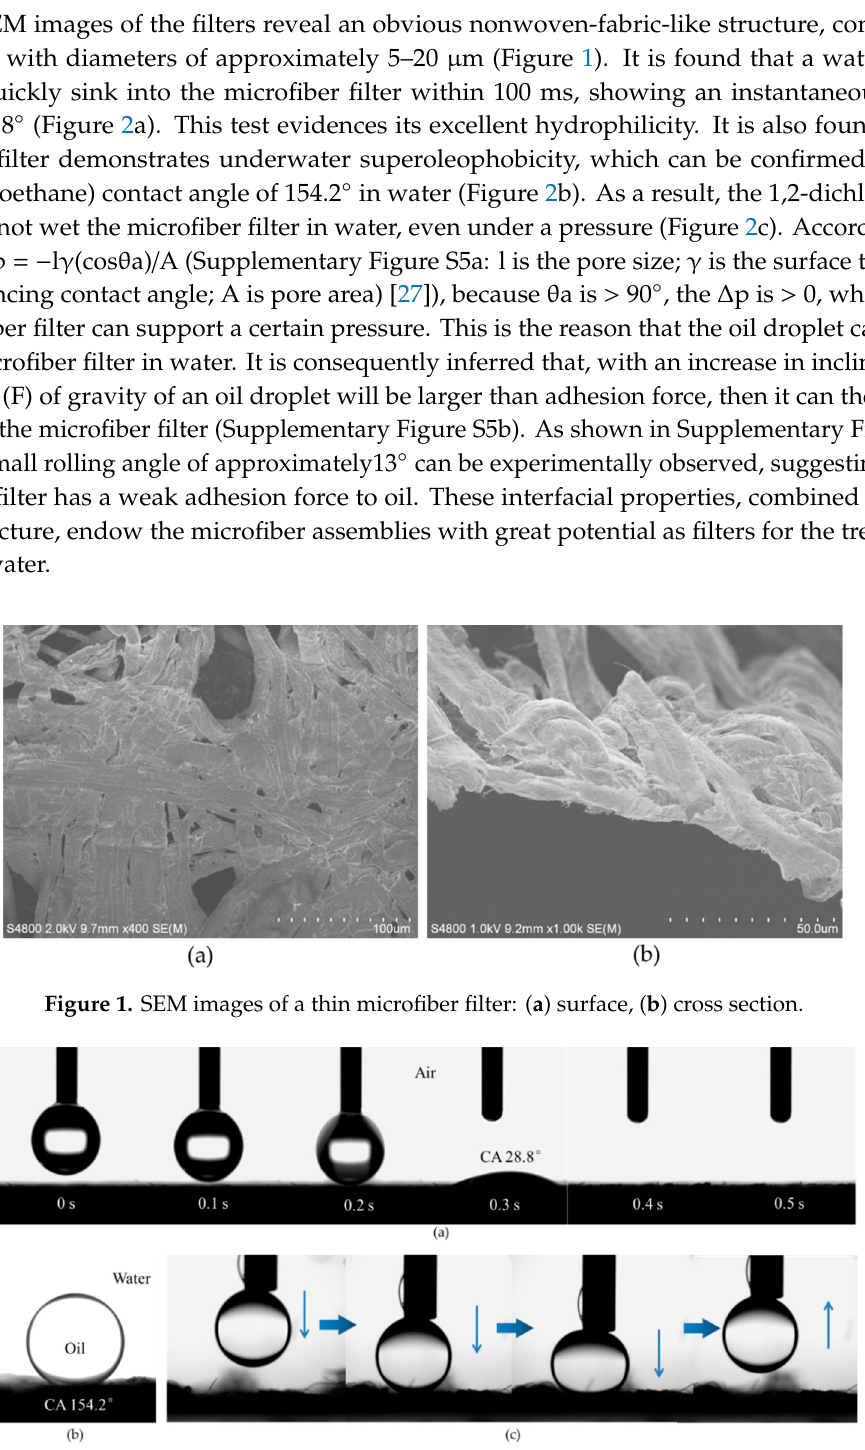
Figure 2. ( a ) Dynamic contact angles of a water droplet on microfiber filter in air; ( b ) Contact angle of 1,2-dichloroethane on microfiber filter in water; ( c ) Photographs of a 1,2-dichloroethane droplet contacting with and leaving from the microfiber filter.